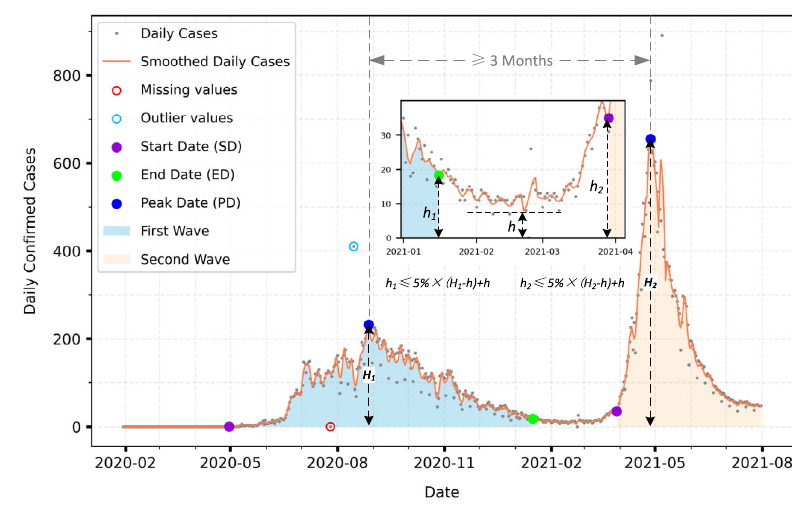
Fig. 4 COVID-19 wave characterization. Illustrating COVID-19 data processing and waves